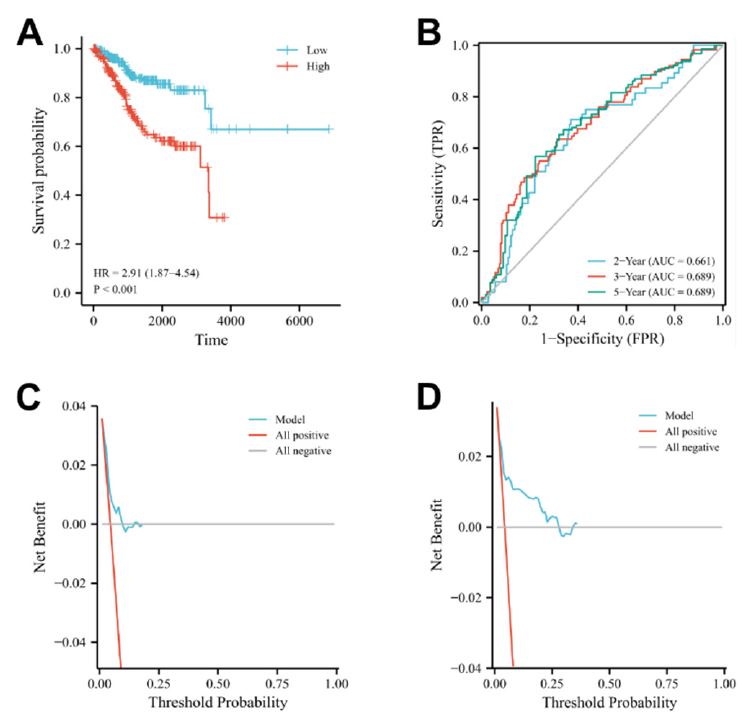
Figure 5. Evaluation of the 7 oxidative stress-related DEGs: ( A ) Kaplan-Meier curves show that OS was significantly different between the high- and low-risk groups in TCGA-UCEC; ( B ) The signature is shown by the time-dependent ROC curve for predicting 2, 3, and 5-year survival; ( C , D ) Decision curve analysis for the evaluation of the net benefits of seven oxidative stress-related DEGs model at1 years. Note: UCEC: uterine corpus endometrial carcinoma; DEGs: differentially expressed genes.